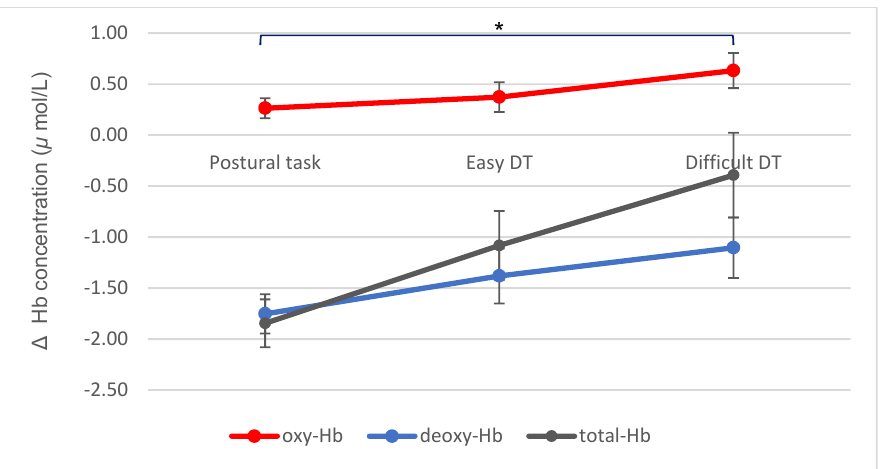
Figure 3. Changes in hemoglobin concentrations in the prefrontal cortex during the postural task and dual-task (easy and difficult) performance. The y-axis displays relative concentration (median values and standard error (error bars)) changes of hemoglobin (Hb in µ mol/L). The x-axis displays tasks performance: postural task (single-task), easy DT (easy dual-task), difficult DT (difficult dual-task). The oxyhemoglobin concentration, [oxy-Hb], is indicated by the red line, the deoxyhemoglobin concentration, [deoxy-Hb], by the blue line, and total hemoglobin concentration, [total-Hb], by the grey line. * p < 0.05 in changes [Oxy-Hb], [deoxy-Hb] and [total-Hb] between the difficult dual-task and postural task (Friedman test with Bonferroni correction).